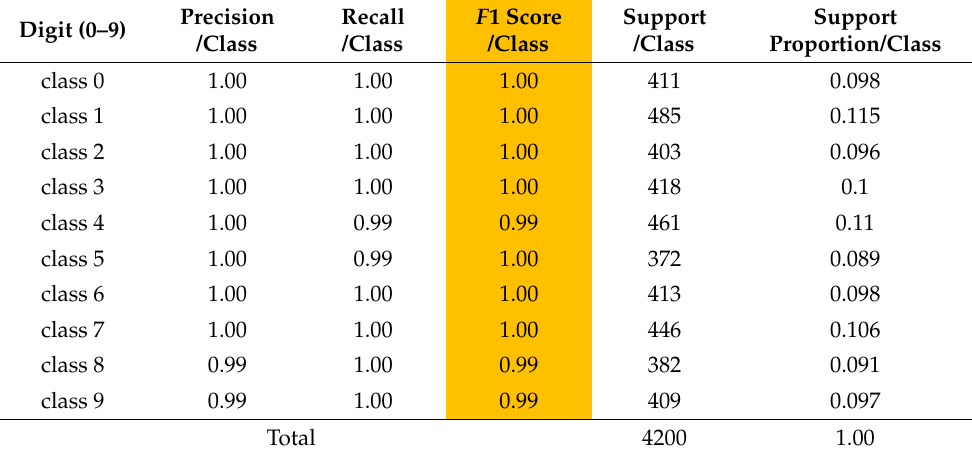
Table 3. Classification report of model M2 for 0–9